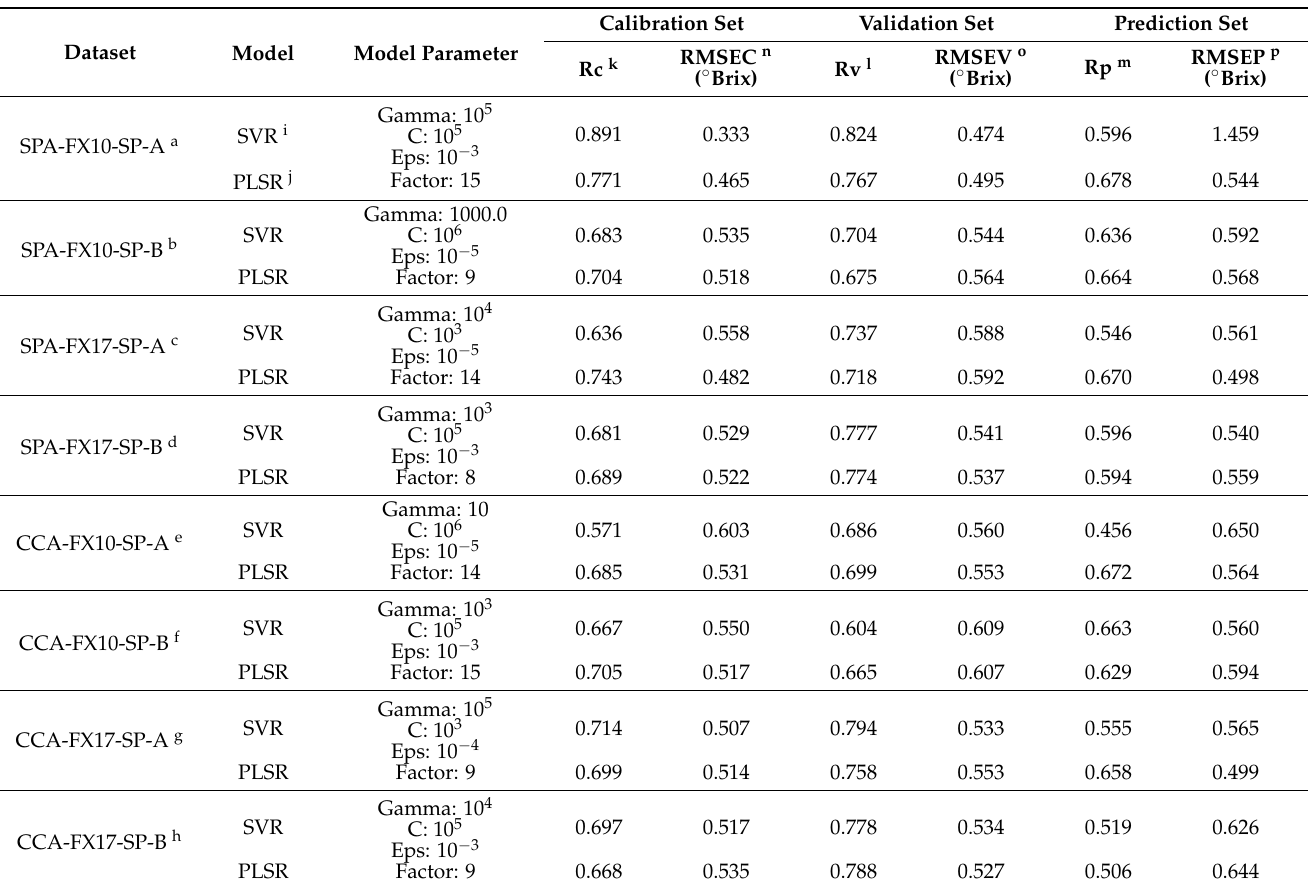
Table 4. Results and parameters of the calibration, validation, and prediction sets by SVR and PLSR models using identified characteristic